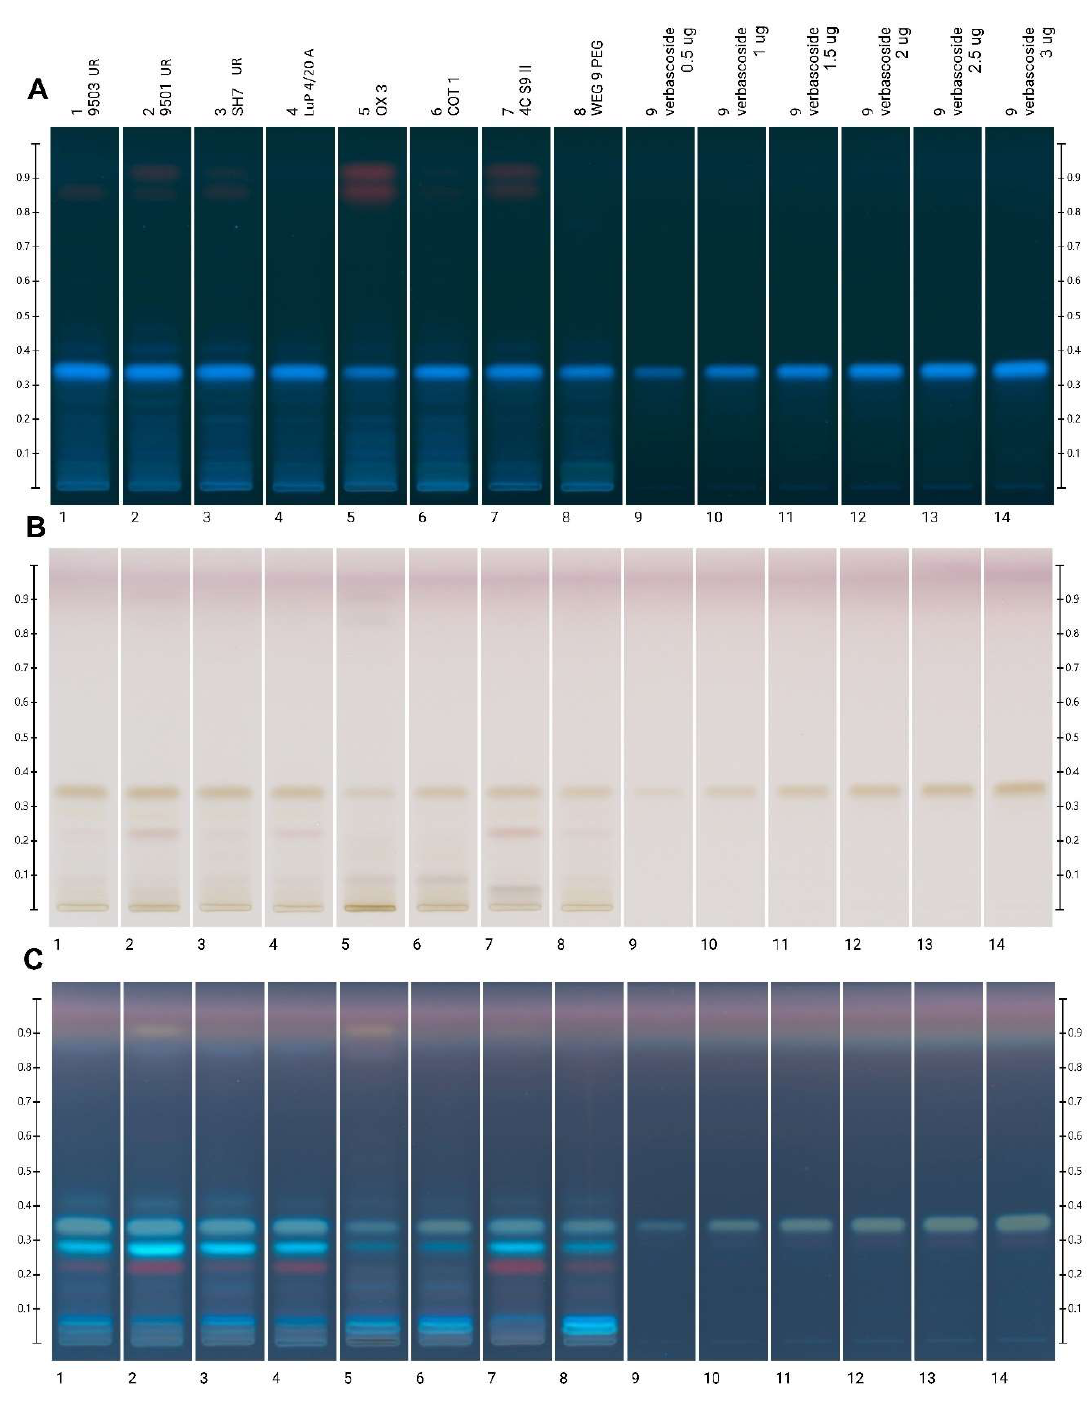
Figure 4. HPTLC chromatograms of selected clones dry extracts and verbascoside calibration curve. ( A )—without derivatization in UV 366 nm, ( B )—after p-anisaldehyde sulfuric acid reagent derivatization in white light, ( C )—after p-anisaldehyde sulfuric acid reagent derivatization in UV 366 nm.